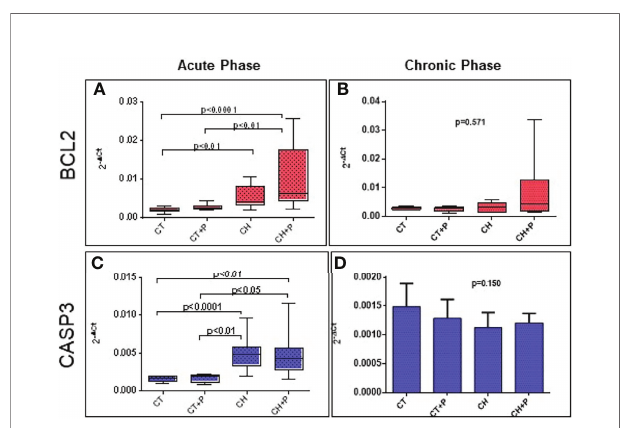
FIGURE 5 | Gene expression of apoptosis genes. (A) BCL2 gene expression in the acute phase (n=49); (B) BCL2 gene expression in the chronic phase (n=38). (C) CASP3 gene expression in the acute phase (n=49); (D) CASP3 gene expression in the chronic phase (n=38). CT - control group, CT+P – control group exposed to pollution, CH – chagasic group, CH+P – chagasic group exposed to pollution.